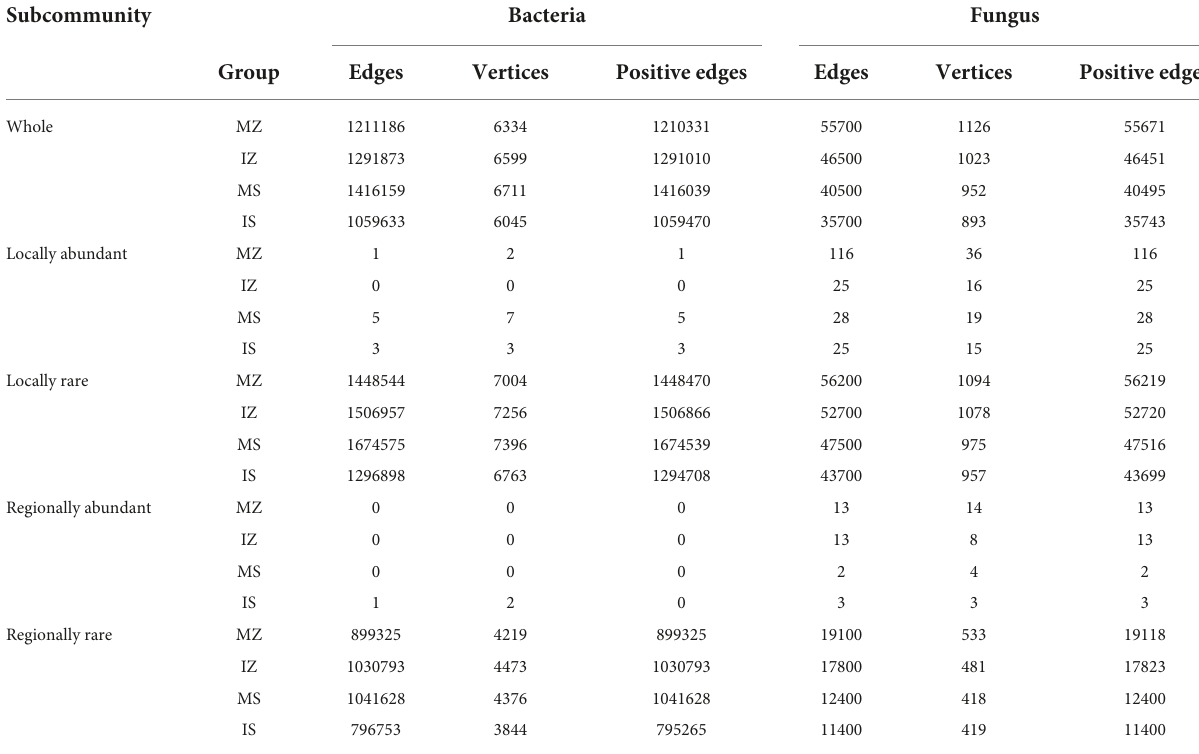
TABLE 1 Properties of subcommunity microbial association network in different